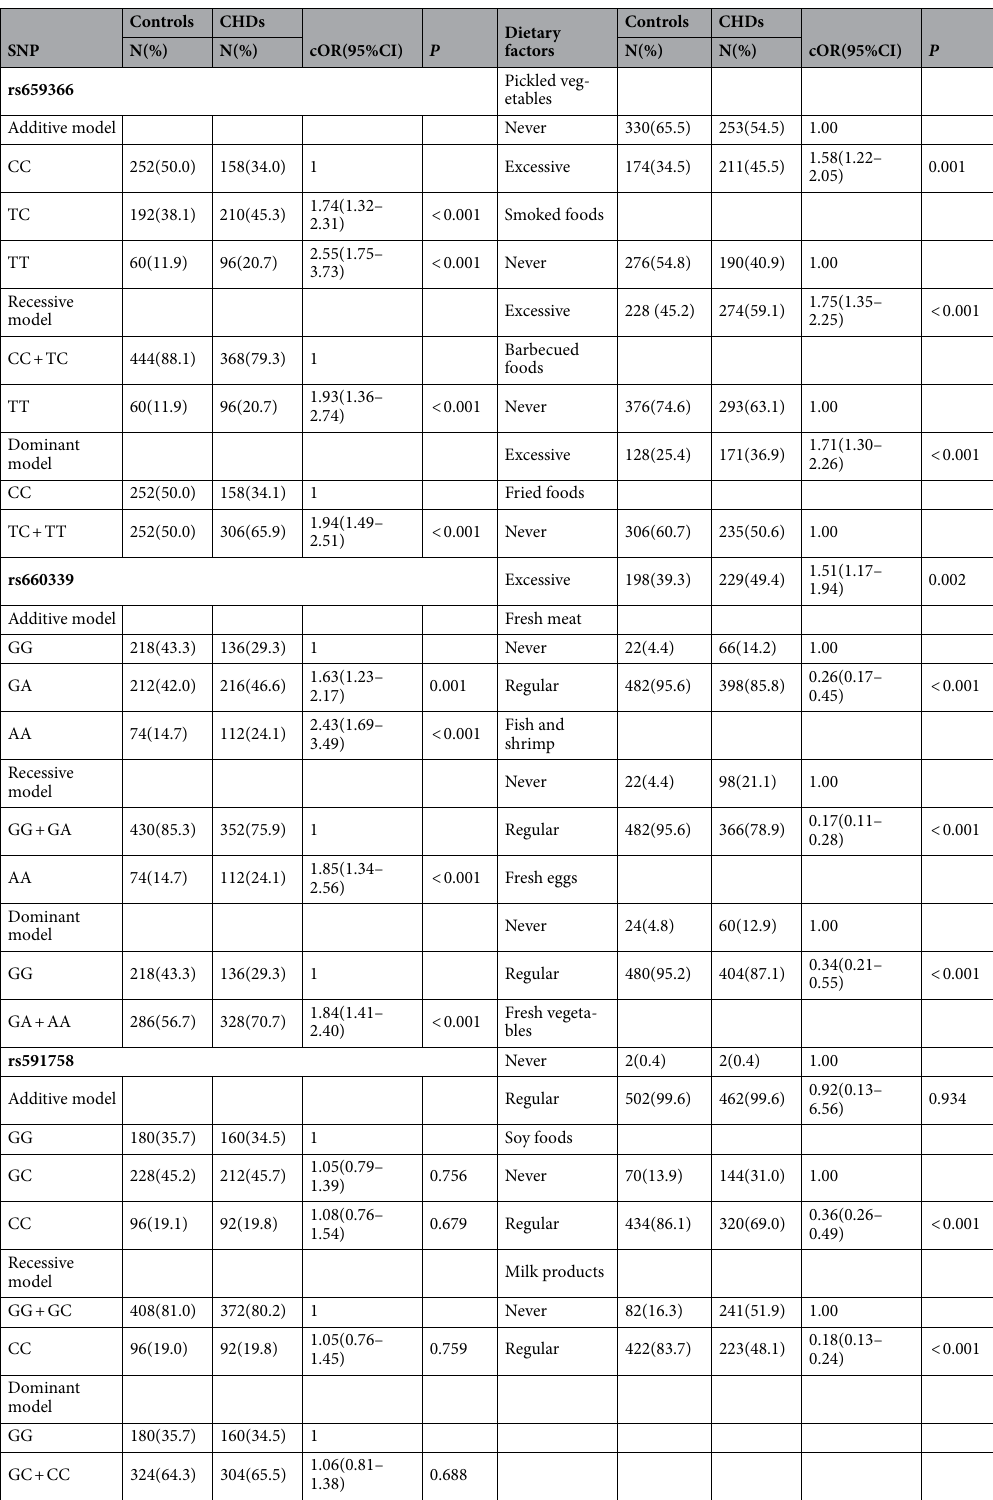
Table 2. The association of the UCP2 gene and dietary factors with CHDs in univariate analyses. CHDs congenital heart diseases; cOR crude odds ratio; CI confidence interval; SNPs single nucleotide polymorphisms; *Recessive model means homozygous variant vs heterozygous variant + homozygous wild- type. † Dominant model means homozygous variant + heterozygous variant vs homozygous